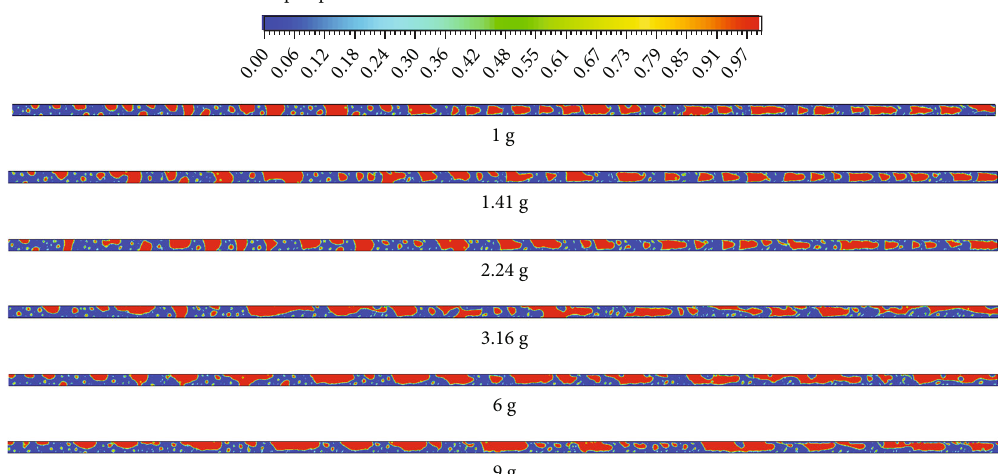
Figure 6: Diagram of boiling fl ow patterns of 0.02% nano fl uid at gravity levels from 1g to 9 g (The gravity direction is downward perpendicular to the fl ow